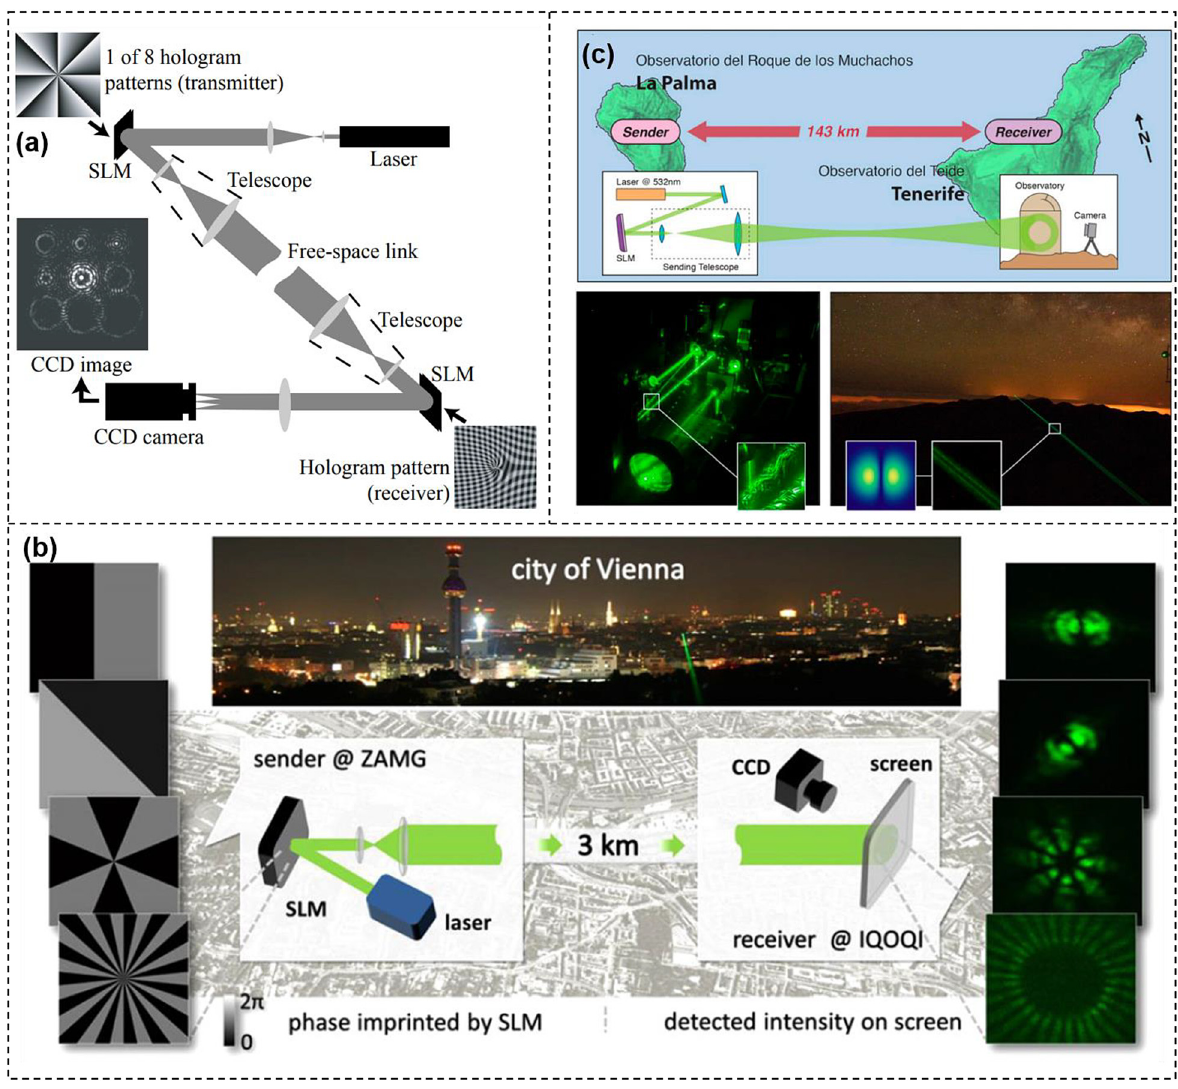
Figure 5: OAM modulation communications using